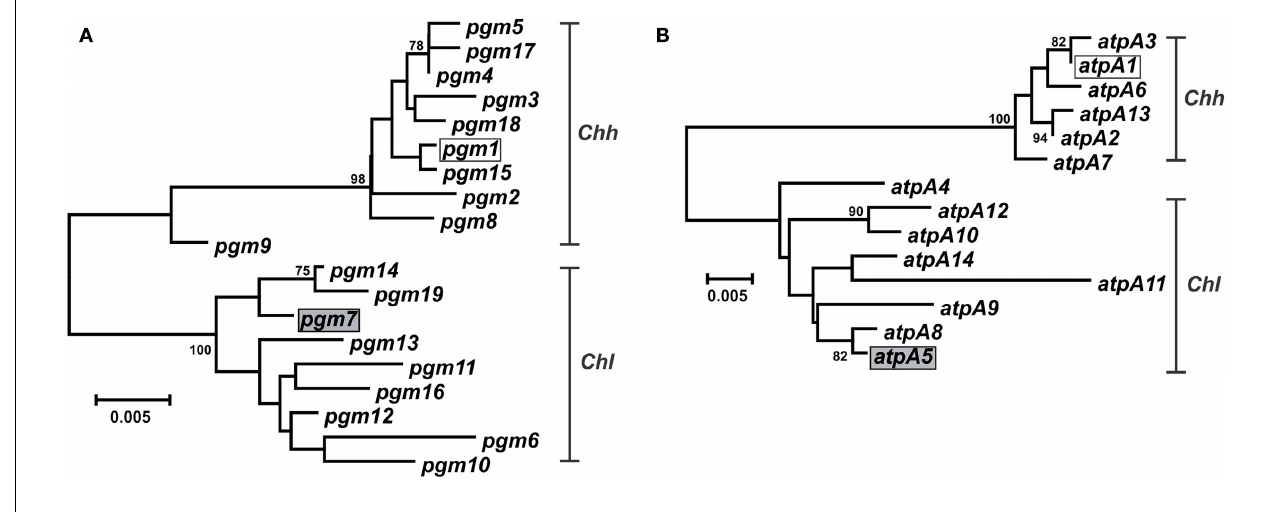
(Kimura, 1980). Bootstrap values > 75%, generated from 1000 replicates, are shown at the nodes. Scale bar represents substitutions per site.The alleles of the Chh (open boxes) and Chl (gray boxes) genome sequence strains are